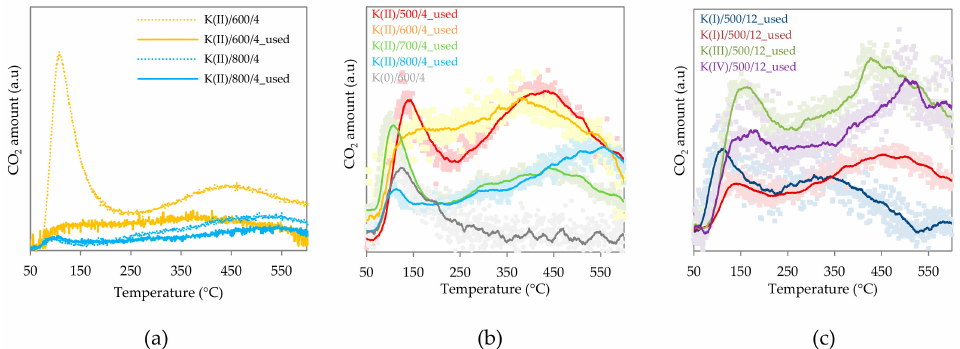
Figure 5. Temperature programmed reduction (TPD) CO 2 results: ( a ) Fresh (dashed line) and used (full line) samples calcined at 600 or 800 ◦ C for 4 h, ( b ) e ff ect of calcination temperature over K(II) / y / 4_used samples calcined at di ff erent temperatures and ( c ) e ff ect of K amount over used samples (K( x ) / 500 / 12_used) calcined at 500 ◦ C for 12